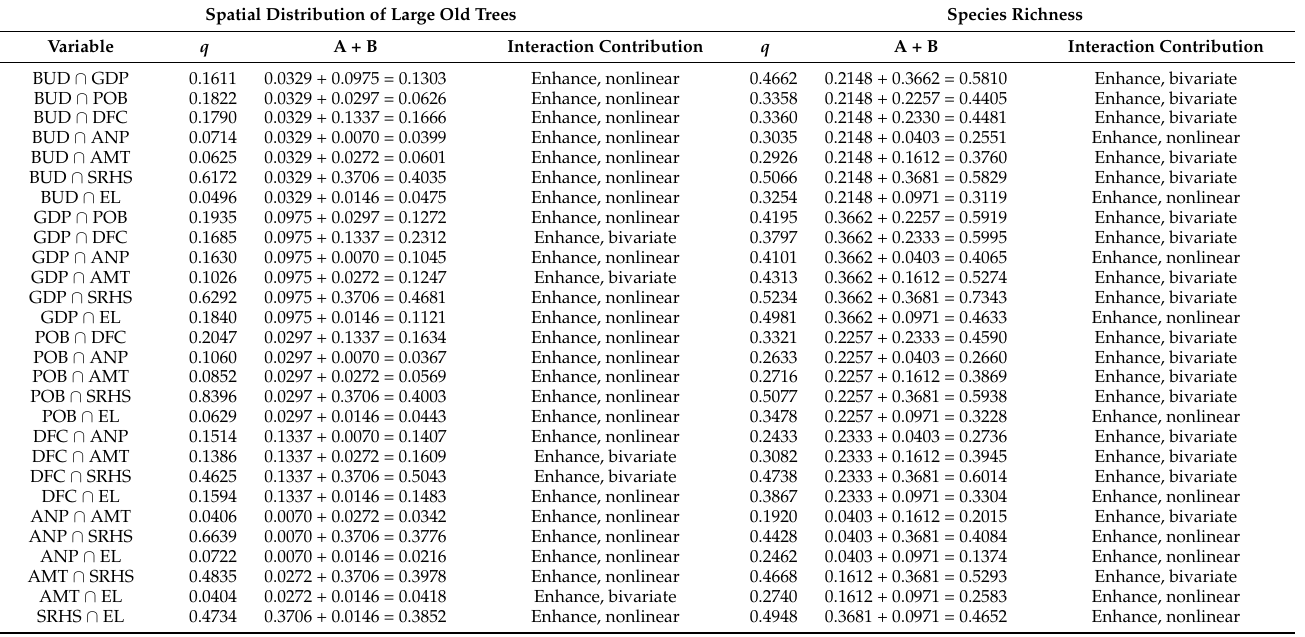
Figure 5. The influence of the interaction between the explanatory variables on the spatial distribution of large old trees ( a ) and the distribution of tree species ( b ). Table 5. Interaction effects of explanatory